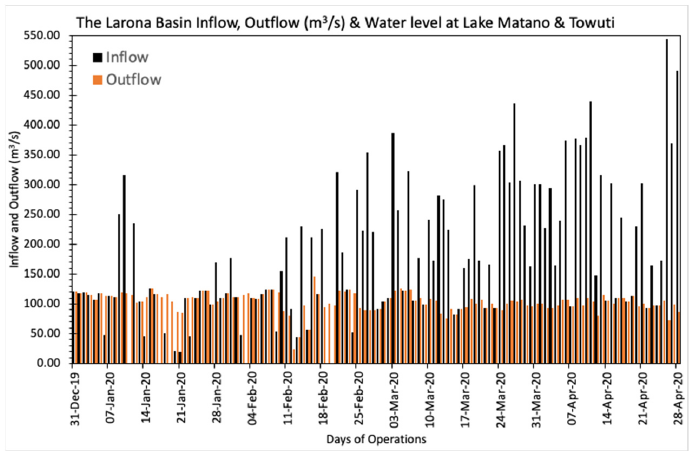
Figure 10. The resulting inflow (black bars) and outflow (orange bars) measurements’ (in m 3 /s) his- togram from the entire (Larona) basin for the 120 days (31 December 2019–28 April 2020) of GBG